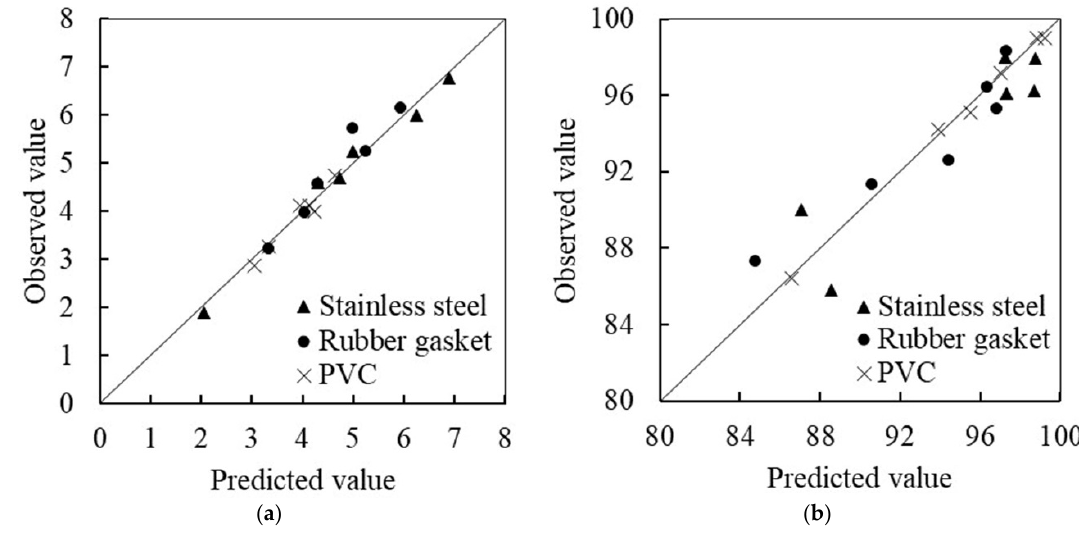
Figure 2. Observed and predicted bacterial reduction and ATP removal rates for three materials under 6 additional random experiments: ( a ) bacterial reduction (log 10 CFU/cm 2 ); ( b ) ATP removal rate (%).